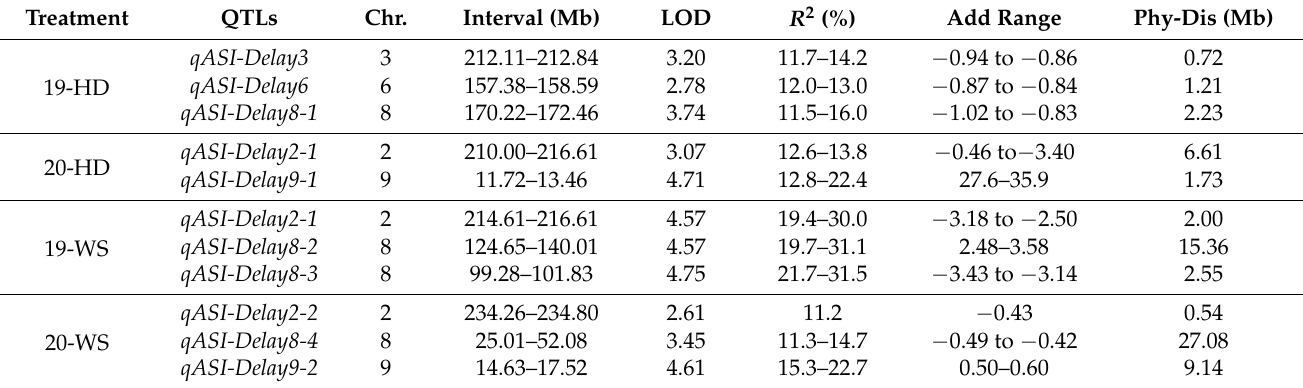
Table 5. QTLs identified for ASI-delay caused by water stress and high planting density during 2019 and